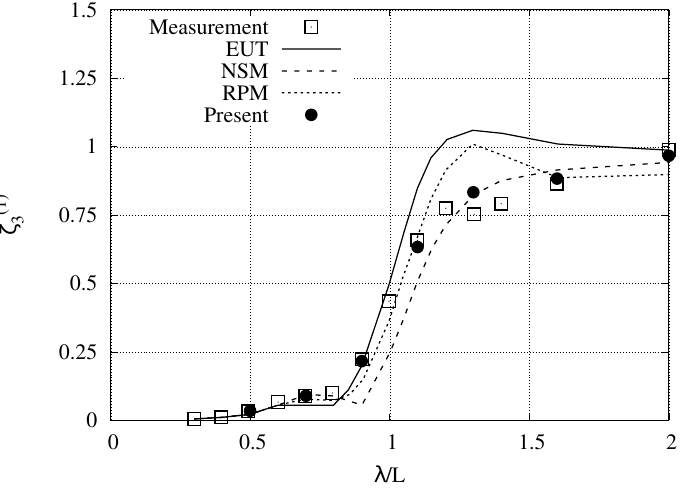
Figure 5. The first harmonic amplitude of the heave against the wave length.